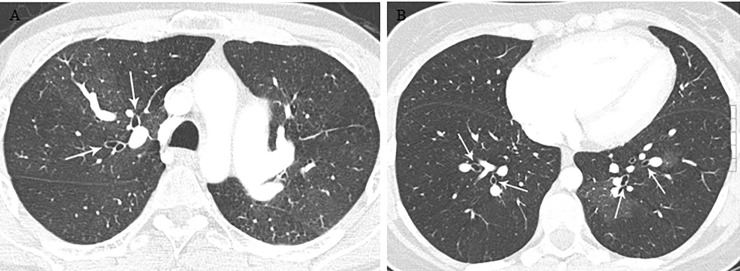
Bronchial dilatation in patients with CTEPH.(A) Axial CT image shows dilated bronchi (arrows) in the right upper lobe. (B) Axial CT image shows dilated bronchi (arrows) in both lower lobes.